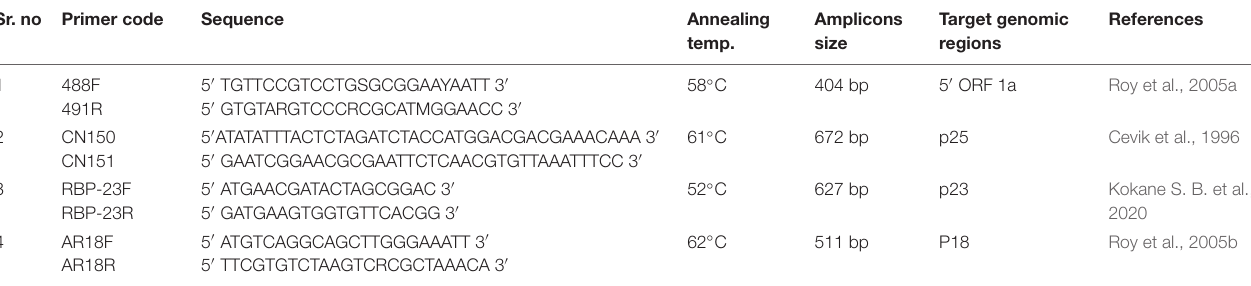
TABLE 2 | Details of the primers used in the present